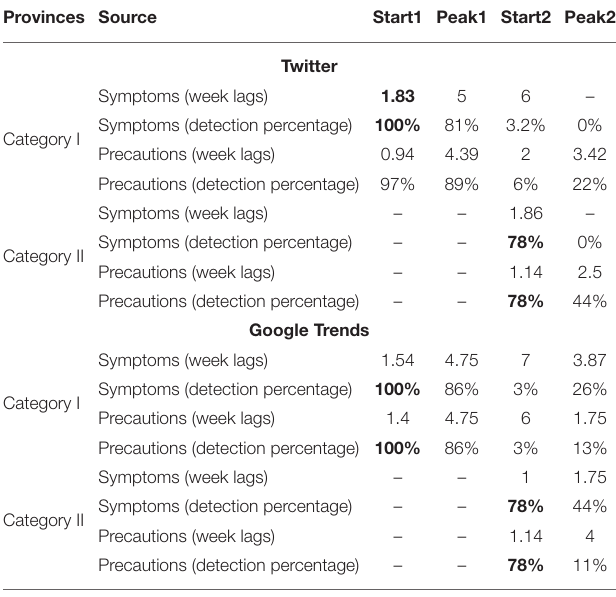
TABLE 3 | The average prediction value of the US states.